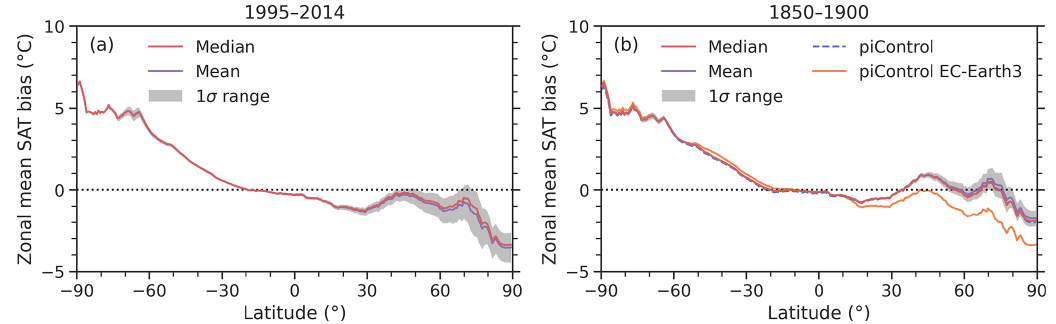
Figure 8. Zonal mean surface air temperature (SAT) bias as a function of latitude for the years 1995–2014 (a) and 1850–1900 (b) . In panel (a) , the bias is calculated with respect to the ERA5 reanalysis; to calculate the bias for the early historical period displayed in panel (b) , the 1995–2014 mean SAT fields from ERA5 have been reduced by the warming between the two periods, estimated from the temperature anomaly fields from HadCRUT4 infilled by kriging (Cowtan and Way version 2.0). Both panels show the median, mean, and 1 standard deviation range of the bias from the four realizations of the CMIP6 historical simulation. For comparison, panel (b) also shows the deviation of the 500-year mean from the preindustrial control simulation from the observational estimate for 1850–1900, for both EC-Earth3-AerChem and